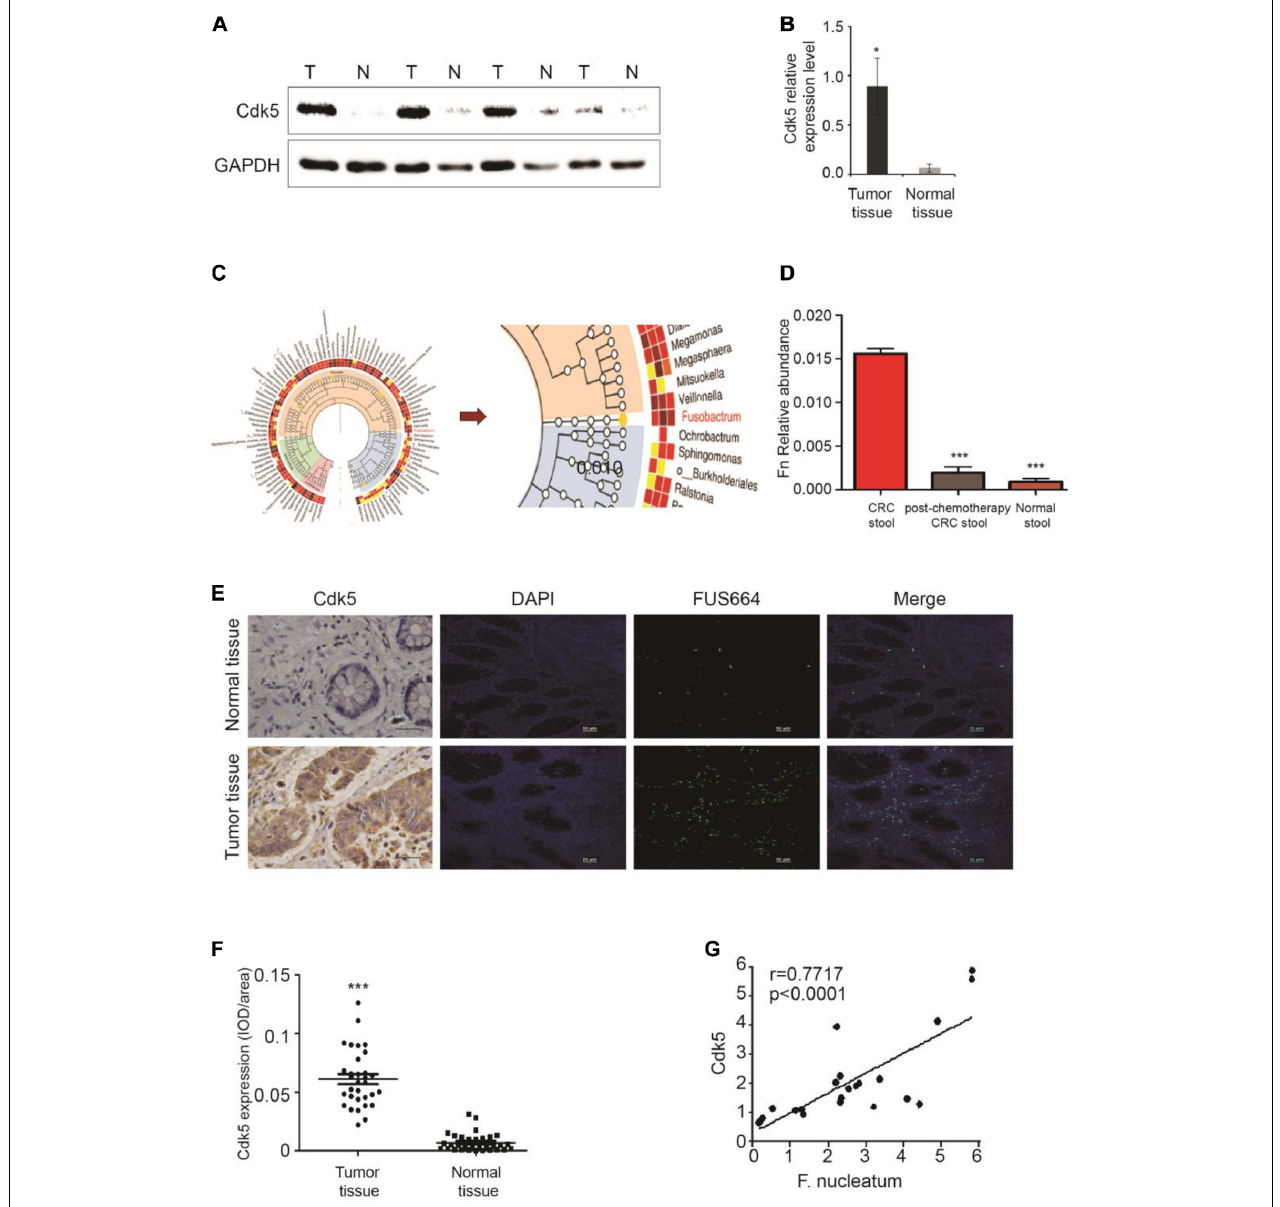
FIGURE 1 | Upregulation of cyclin-dependent kinase 5 (Cdk5) protein expression and its correlation with Fusobacterium nucleatum in colorectal cancer (CRC). (A) Cdk5 protein levels were detected by Western blot (WB) analysis in CRC and normal tissues. (B) Statistical analysis of Cdk5 mRNA expression in (A) (* P < 0.05). (C,D) Fusobacterium abundance was significantly higher in CRC tissues in comparison with controls. (E–G) The abundance of F. nucleatum was positively correlated with Cdk5 expression in tumor tissues. (E) Representative images showing that the abundance of F. nucleatum (green dot) in tumor tissues is associated with high expression of Cdk5. (F) Immunohistochemical scatter statistics of Cdk5 protein levels in 21 CRC tissues and normal tissues from patients (*** P < 0.001, 200 × magnification). (G) Statistical analysis of Cdk5 and F. nucleatum mRNA expression in 18 tumor tissues from patients and 18 healthy controls ( r = 0.7717, P < 0.0001; two-tailed, non-parametric Spearman’s